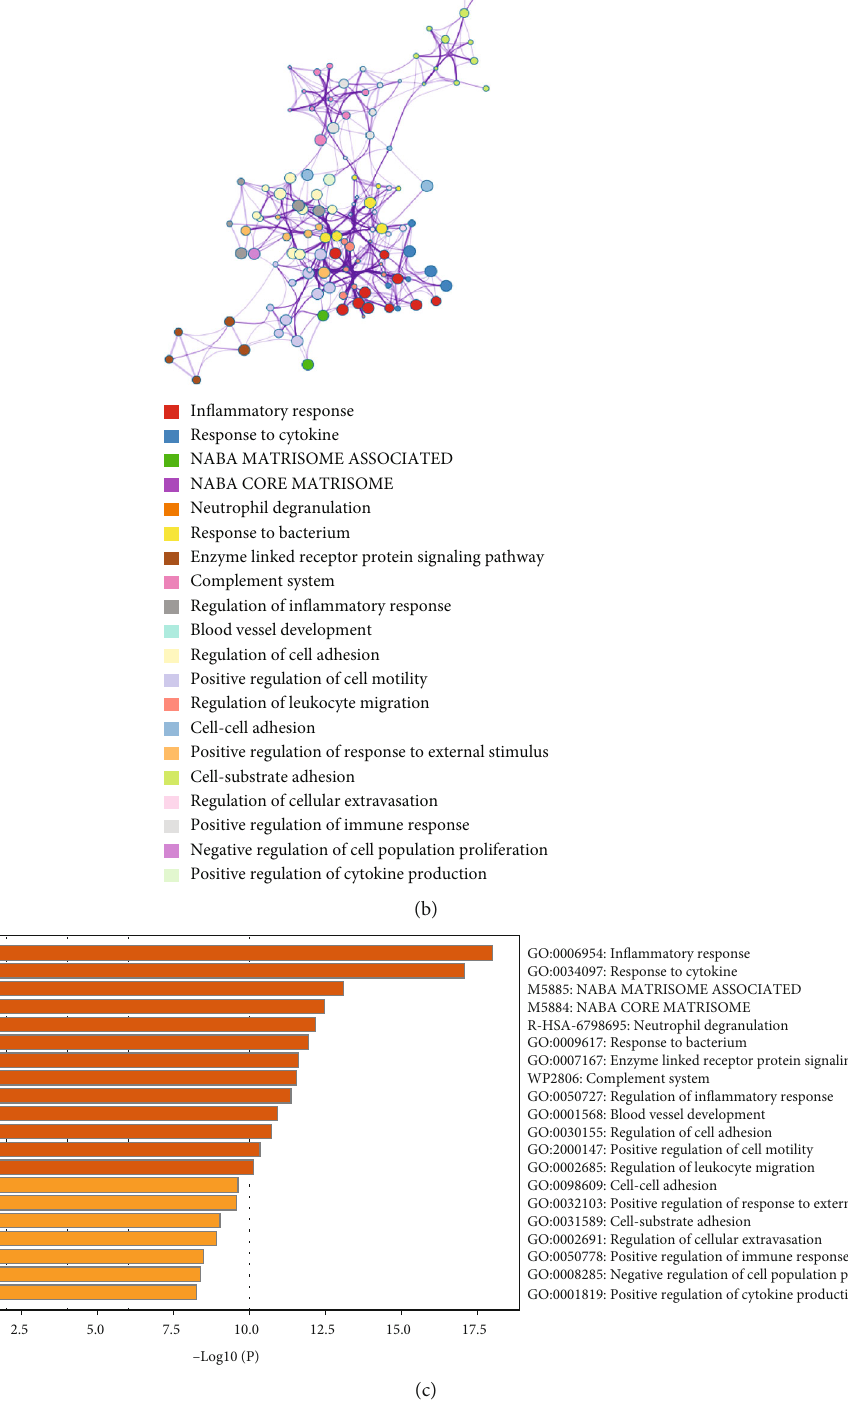
Figure 5: Disease Ontology (DO) and Metascape analyses of DEGs. (a) DO enrichment analysis was performed on DEGs. The x -axis shows the number of genes enriched on the terms, and the y -axis shows the pathway terms. The q value of each term is colored according to the legend. DEGs are di ff erentially expressed genes. (b) The network of the top 20 enriched term clusters. The color indicates cluster identi fi cation, the thickness of the edge indicates the similarity score, and terms with a similarity score > 0.3 are connected by an edge. (c) The top 20 clusters are shown in a heat map. Color is used to indicate cluster identi fi cation: the lower the P value, the darker the